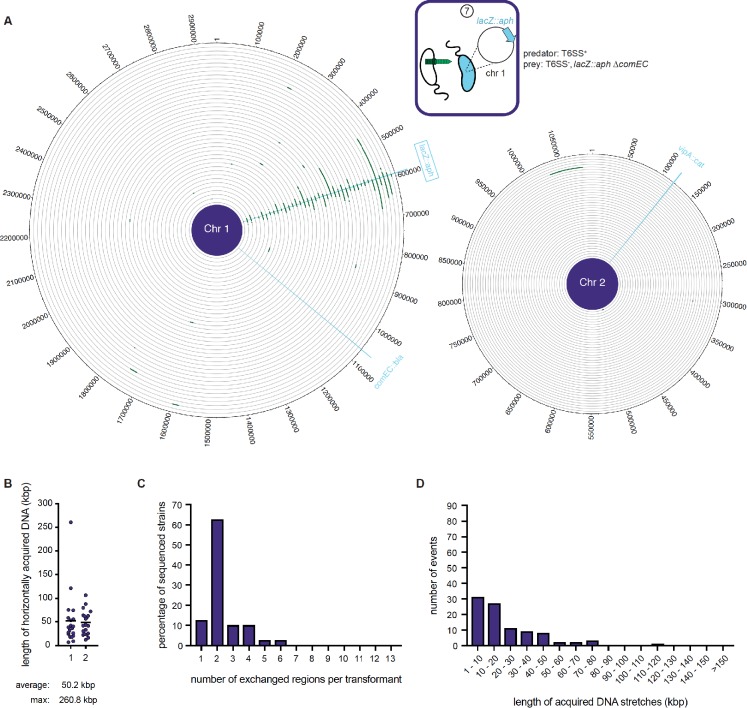
WGS-based quantification of horizontally acquired DNA under condition ⑦.Details as described for Figure 3 with the addition of the map of both chromosomes in panel A.